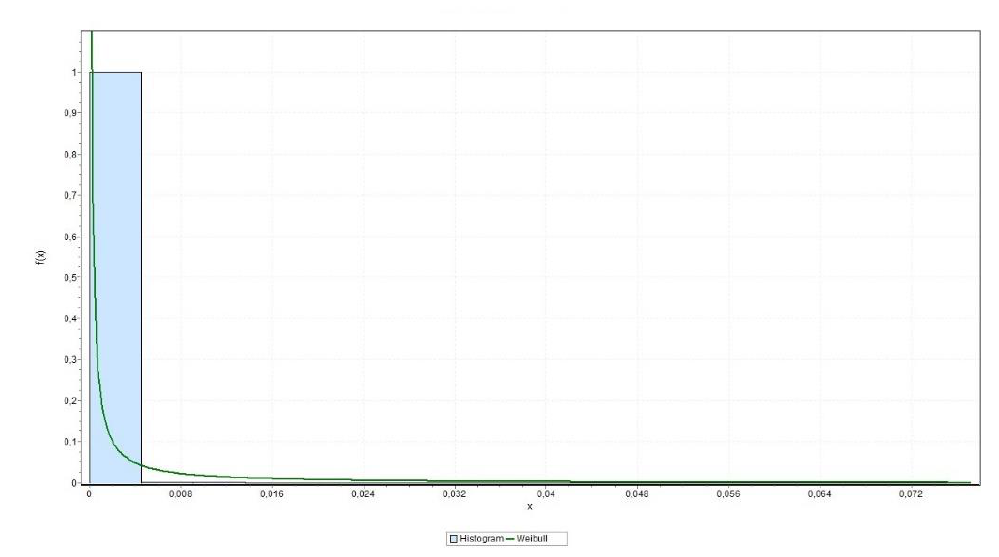
Figure 4. Weibull-distribution of time intervals between packages, the value of the parameters: α 1 =0.13, β 1